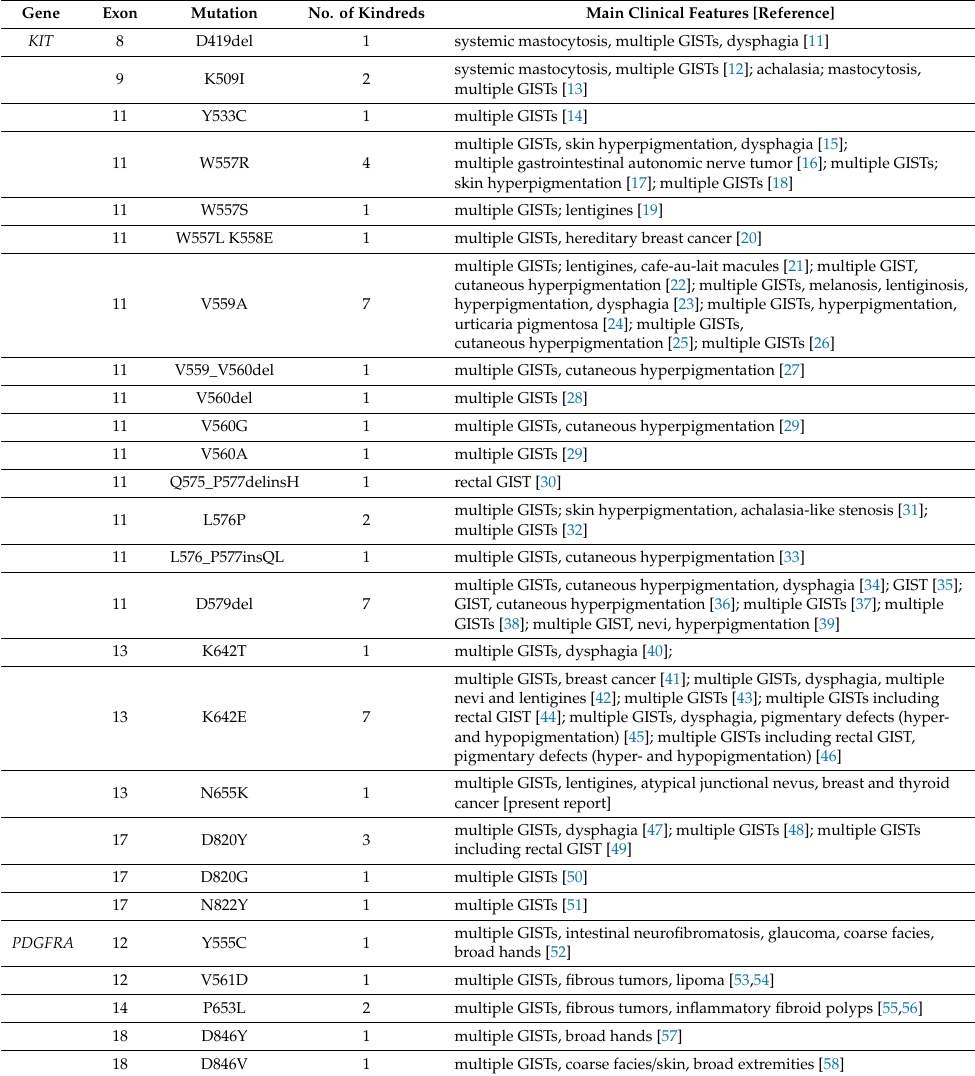
Table 1. Currently reported cases of KIT - or PDGFRA -associated familial Gastrointestinal Stromal Tumors